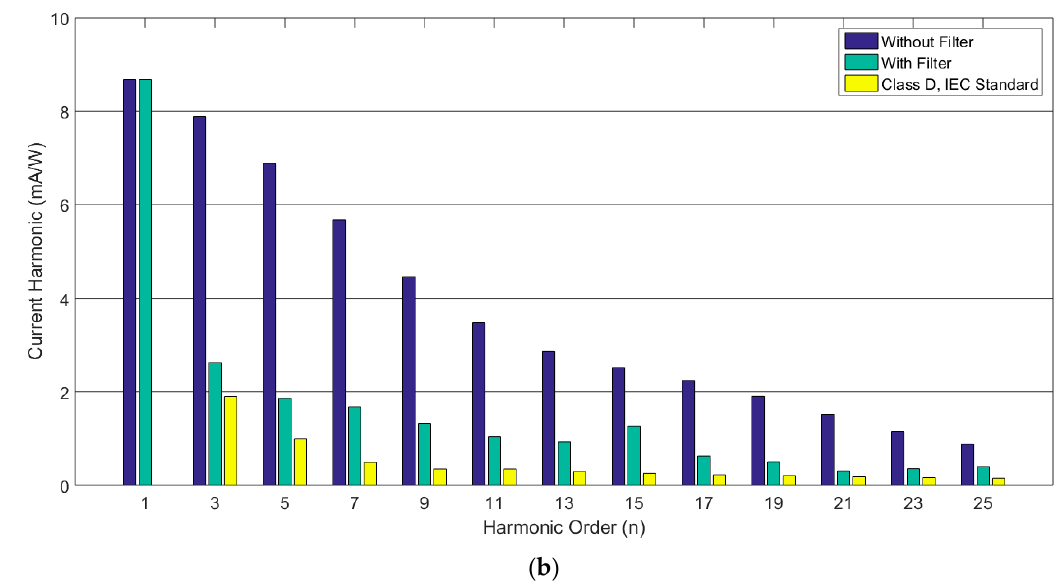
Figure 15. Comparison of harmonic magnitude for lighting system with and without filter including IEC standard. ( a ) LED lamp with external driver including Class C IEC standard; ( b ) LED lamp with external driver including Class D IEC standard.